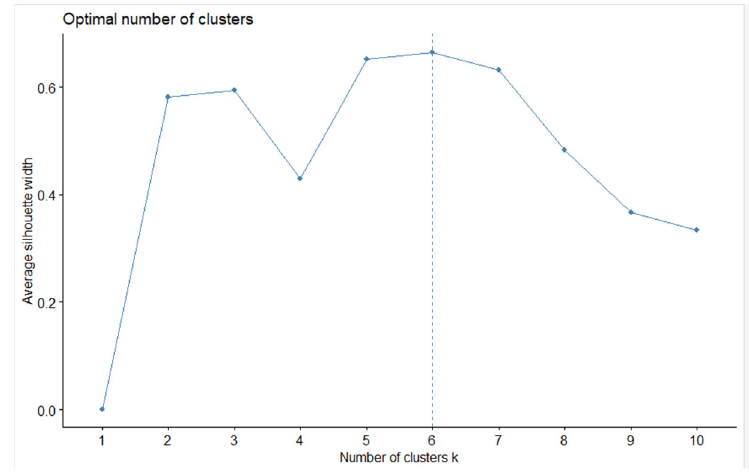
Figure 2. Results of applying the “silhouette” method to the data.